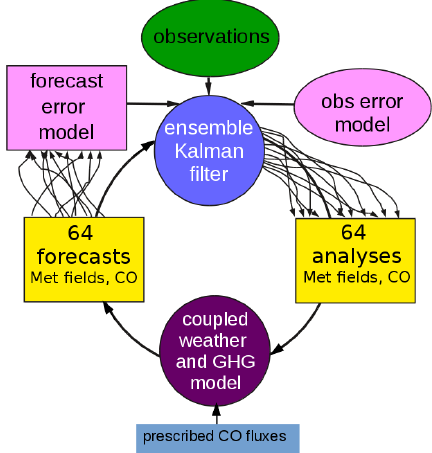
Figure 1. Schematic overview of EC-CAS v1.0. There is an ensem- ble of 64 prescribed CO surface fluxes. In EC-CAS v1.0, surface flux fields are not estimated; instead, the perturbed flux field is used to account for uncertainty in CO due to error in the surface flux. The 64-member forecast ensemble is used along with the observa- tions, and the statistics of observation errors are used as input for the EnKF. The 64 analyses of meteorology and CO generated by the EnKF are used as initial conditions for the next 6h forecast. This cycle repeats every